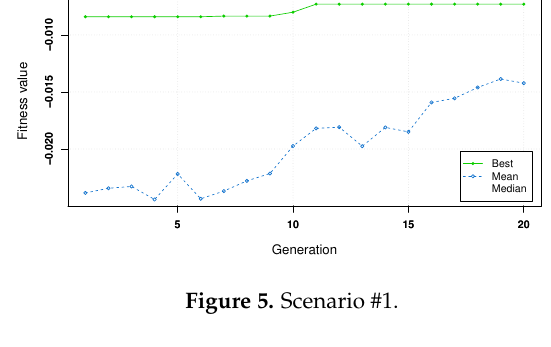
Figure 5. Scenario #1.